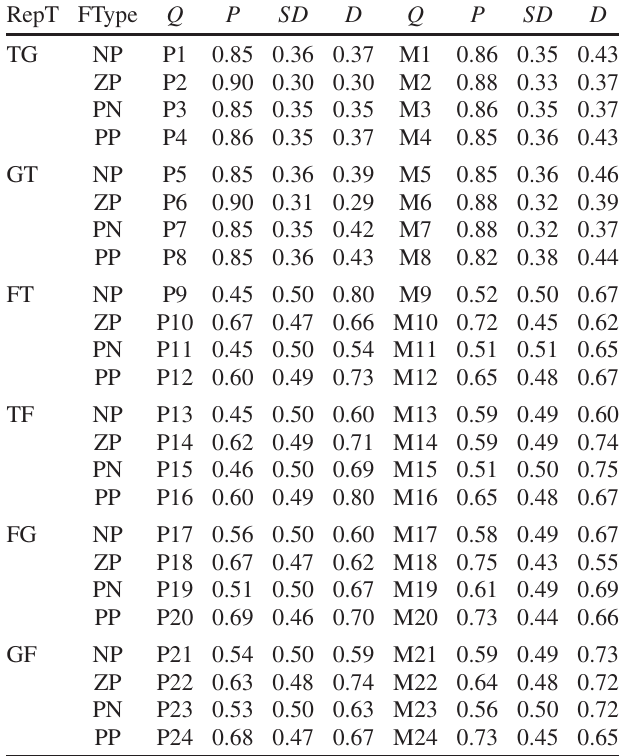
TABLE I. The relevant validation quantities for each question Q of the test: item difficulty index P , the standard deviation SD for P and the item discrimination index D . The items are sorted by representation transition (RepT), function type (FType), and context to simplify interpretation and comparison. Question numbers starting with “ P ” denote a physics context and those with “ M ” a mathematics